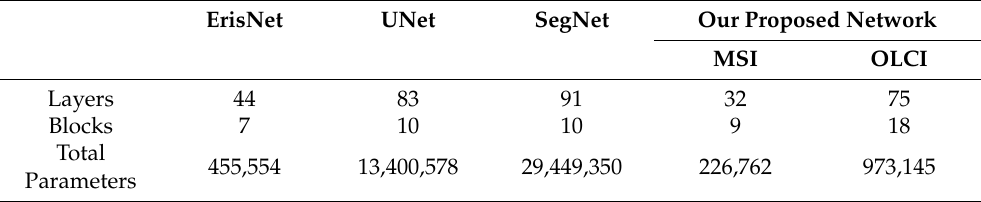
Table 3. Summary of the layer, block and total parameter numbers for ErisNet, UNet, SegNet and our proposed Networks for MSI and OLCI. More detailed tables of the structure of our proposed Networks are available in Supplementary Materials for MSI (Table S3) and OLCI (Table S4). ErisNet